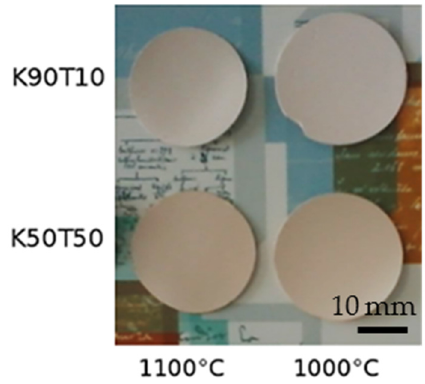
◦ C (soaking time of 12